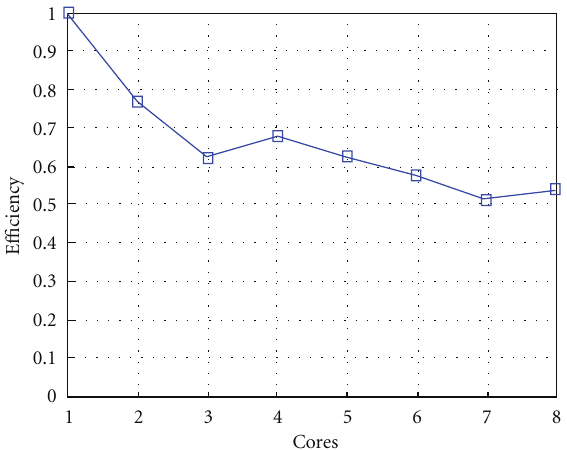
Figure 14: Test 1: Algorithm SI: Parallel e ffi ciency versus the number of cores. Δ τ = 0 . 016.